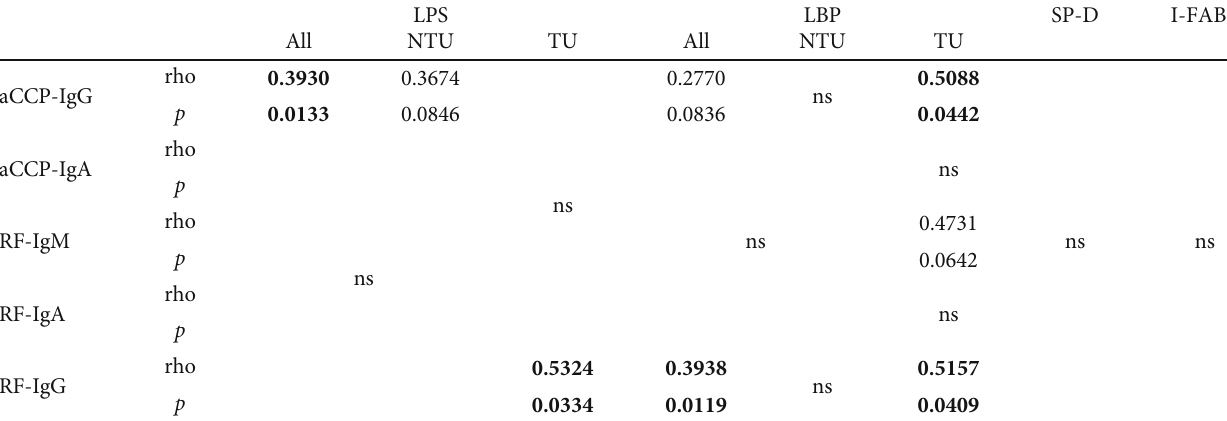
Table 3: Correlations between disease indicators and the various test